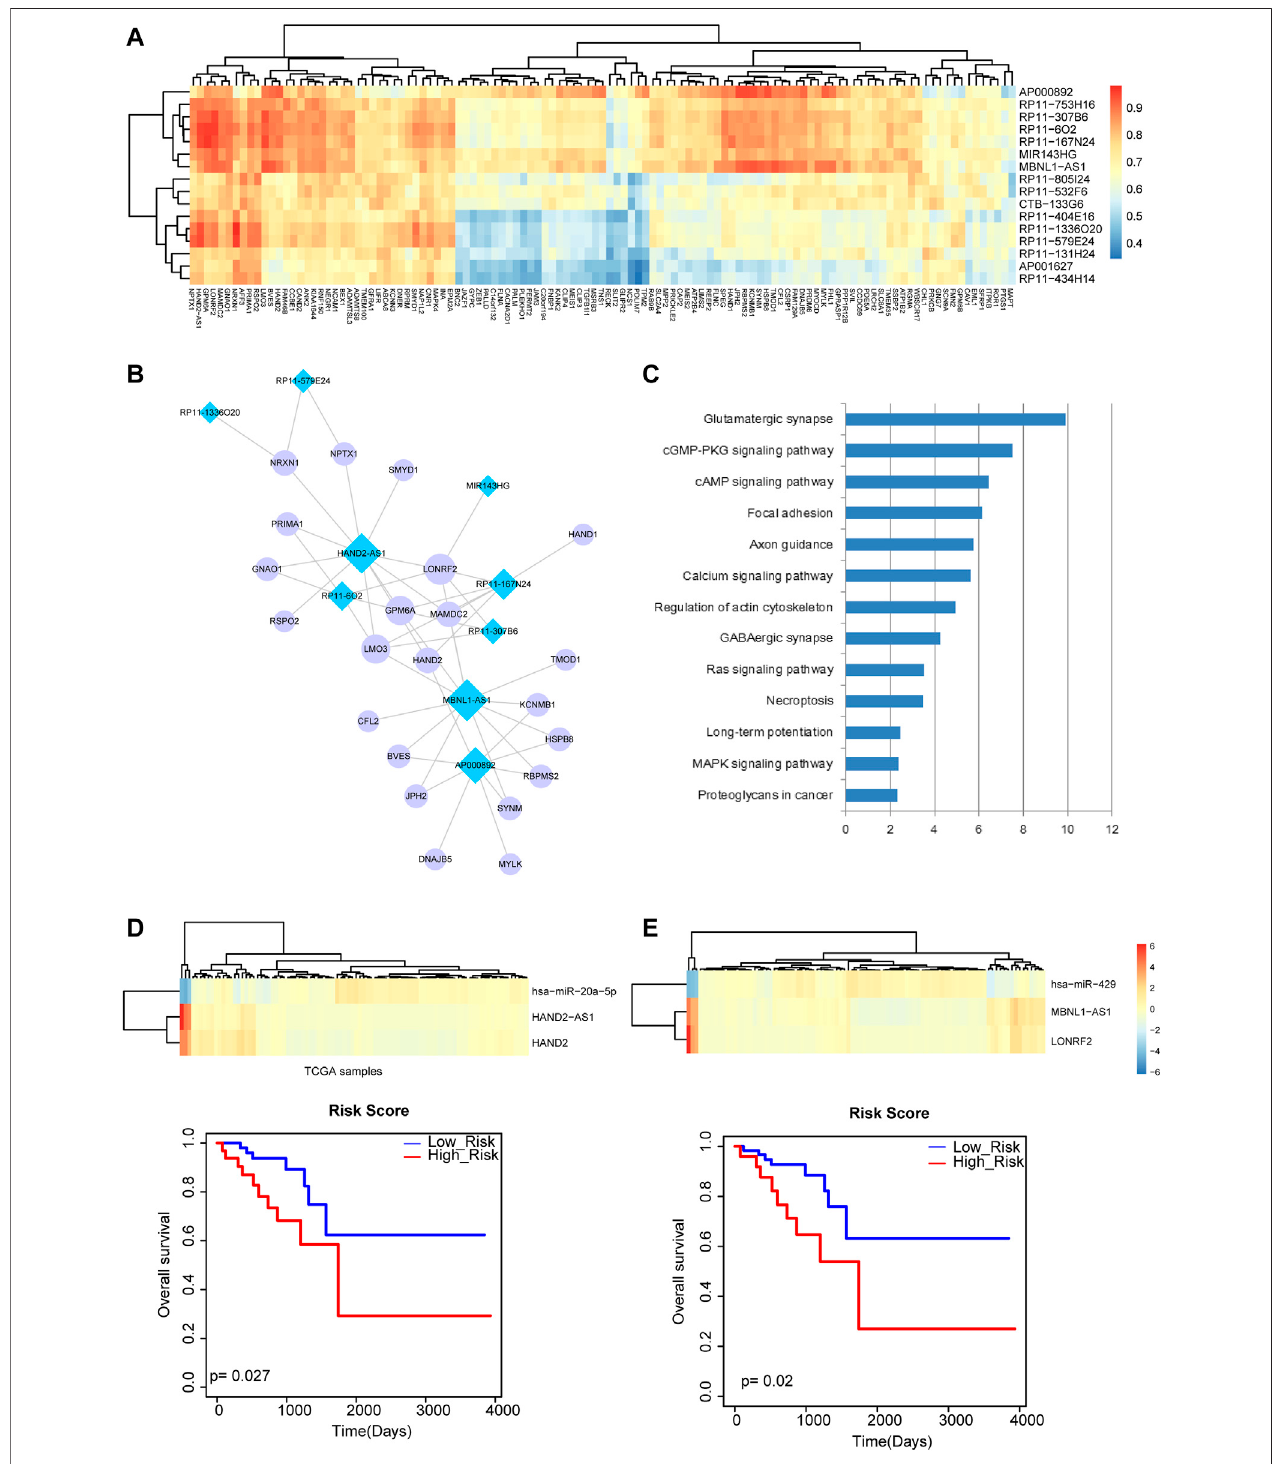
FIGURE4| AnalysisoflncRNA-mRNAnetworkandlncRNA-miRNA-mRNA crosstalk. (A) TheheatmapofcorrelationsbetweenlncRNAsandmRNAsthatshared at least one common miRNA. (B) The rectal cancer-related lncRNA-mRNA ceRNA network. Blue diamond represents lncRNA and purple circular represents mRNA. Node size represents degree of node. (C) Pathway enrichment analysis of the mRNAs in the network. (D) The heat map of HAND2-AS1 , HAND2 and miR-20a-5p and theKaplan-MeiersurvivalcurveofthelncRNA-miRNA-mRNAcrosstalk( p =0.027). (E) Theheatmapof MBNL1-AS1 , miR-429 and LONRF2 andtheKaplan-Meier survival curve of the lncRNA-miRNA-mRNA crosstalk ( p = 0.02).